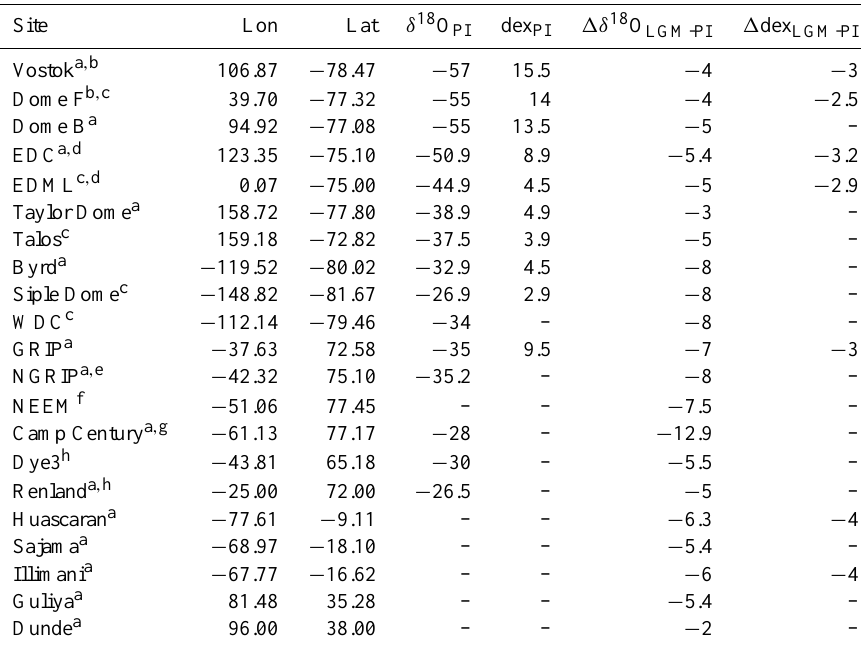
Table 1. Selected ice core records, reported PI and (cid:49) (LGM-PI) values of δ 18 O and deuterium excess (dex). No correction for glacial δ 18 O enrichment has been applied to the listed ice core values. All values are given in permill on the SMOW